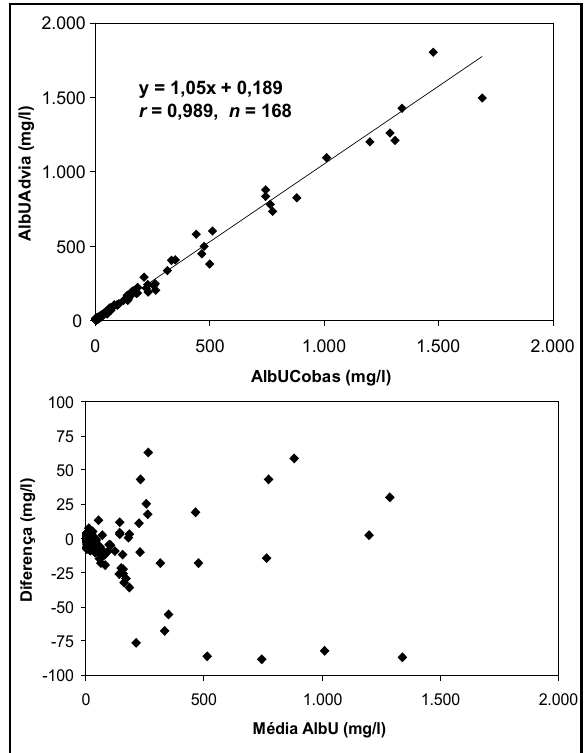
Figura – Concordância analítica entre os métodos: x = AlbuCobas e y = AlbUAdvia; a linha contínua representa x =